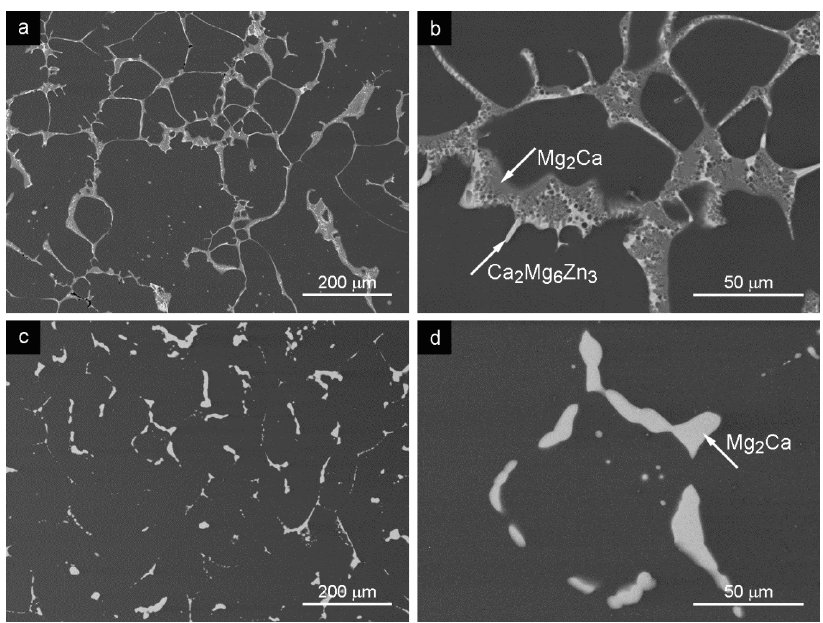
Figure 3. Microstructure of the SCS sample: ( a ) SCS state; ( b ) secondary phases in SCS; ( c ) SCS + HT; ( d ) secondary phases in SCS + HT state depicted in the SEM–BSE mode.